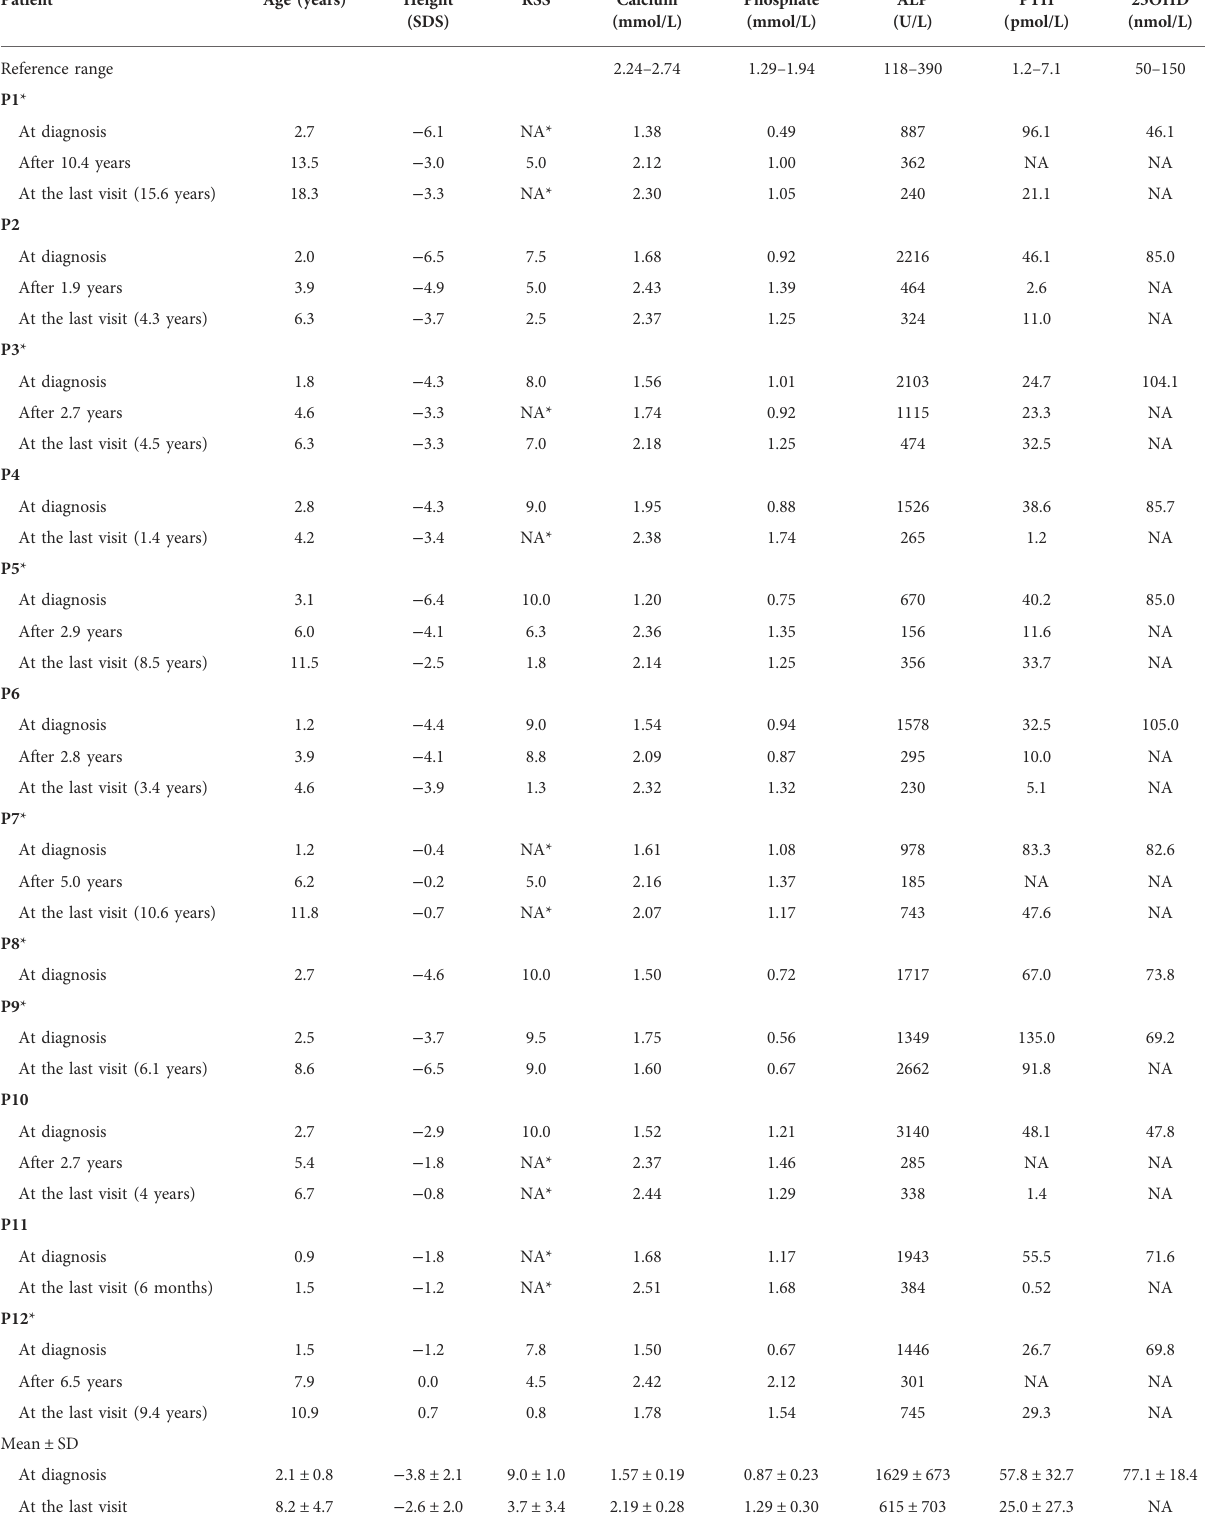
TABLE 2 Growth retardation and biochemical changes of 12 VDDR1A children at diagnosis and after treatment. Patient Age (years) Height